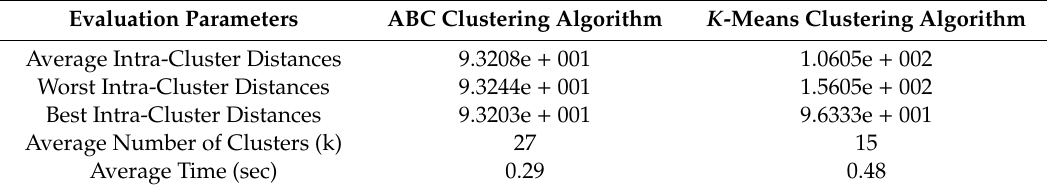
Table 6. Comparison of intra-cluster distances for ABC and K–means clustering